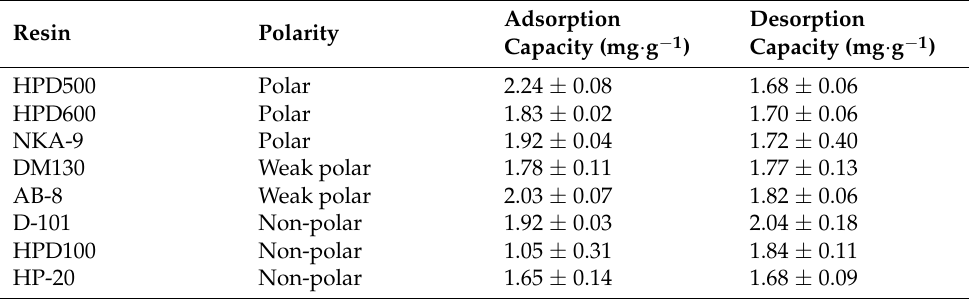
Table 1. The static adsorption and desorption capacity of different resins on